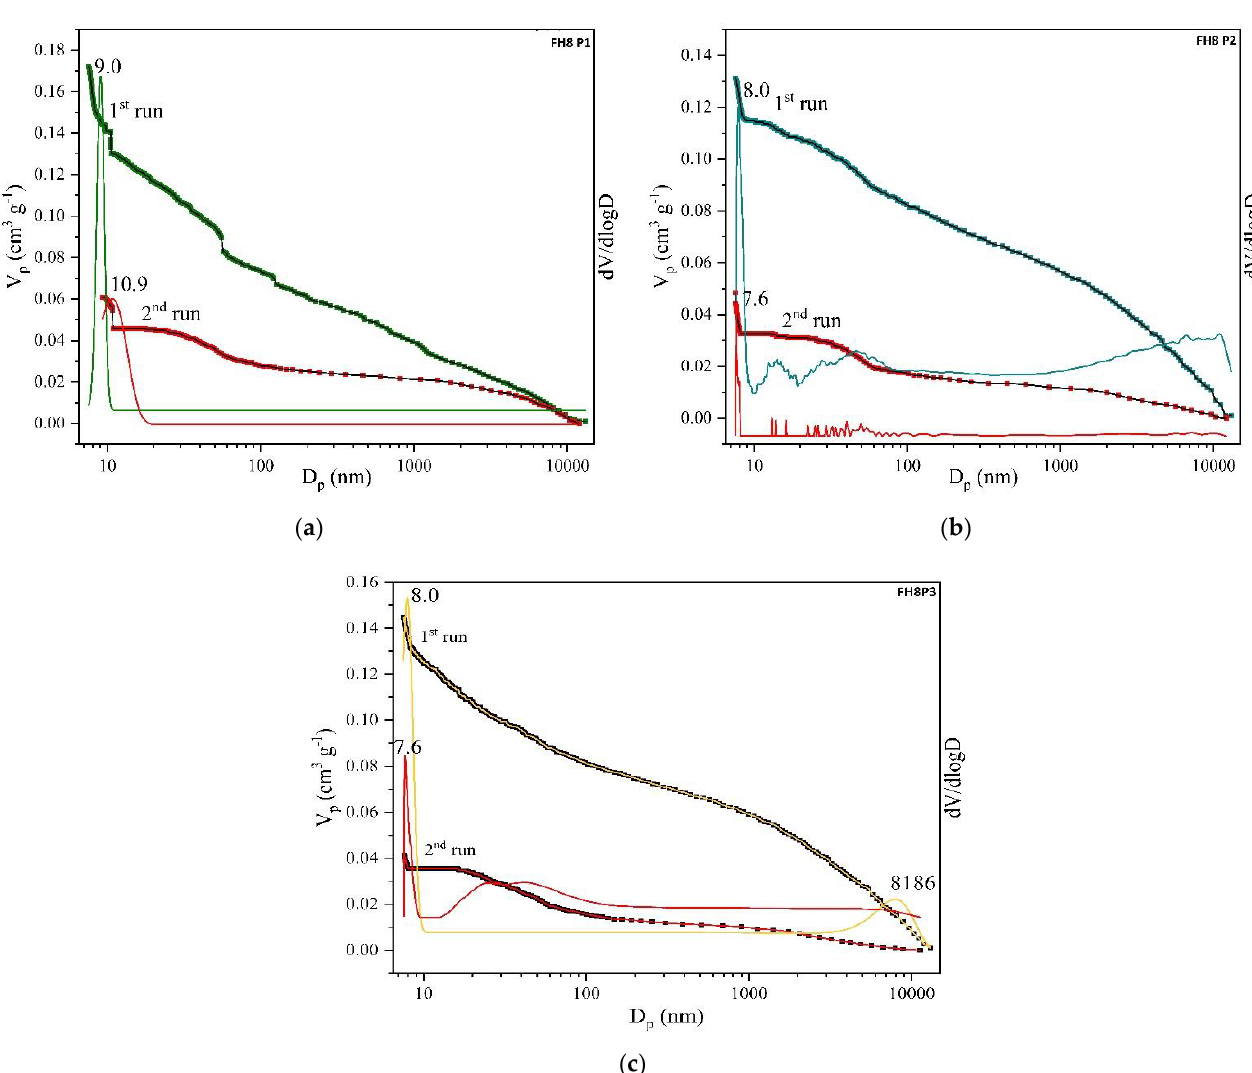
Figure 5. Pore size distribution curves of SLS tablets ( a ) FH8 P1, ( b ) FH8 P2, and ( c ) FH8P3.